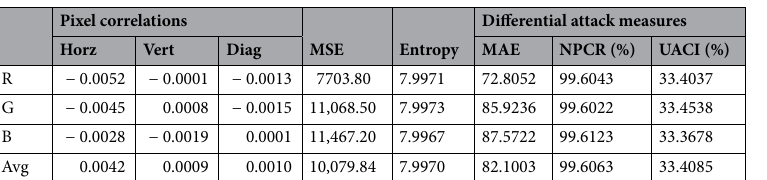
Table 8. Analysis results for encrypted Peppers using the system key K 1